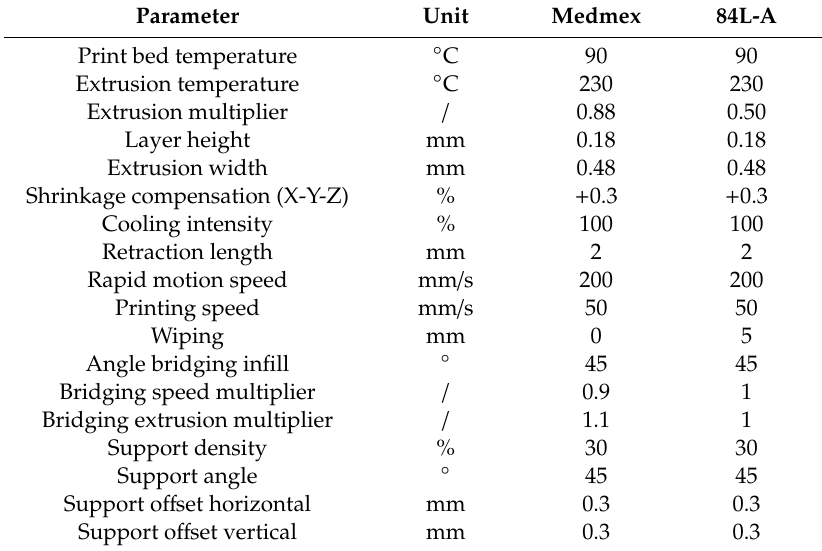
Table 5. Glycol-modified Polyethylene terephthalate (PETG) parameter table, nozzle: 0.4 mm [7].